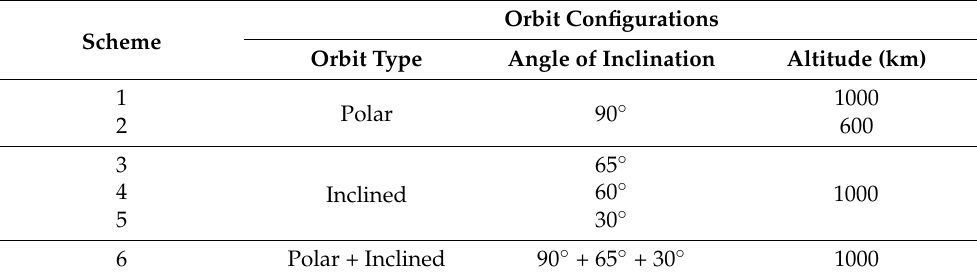
Table 4. Orbital configurations of the designed LEO constellations.